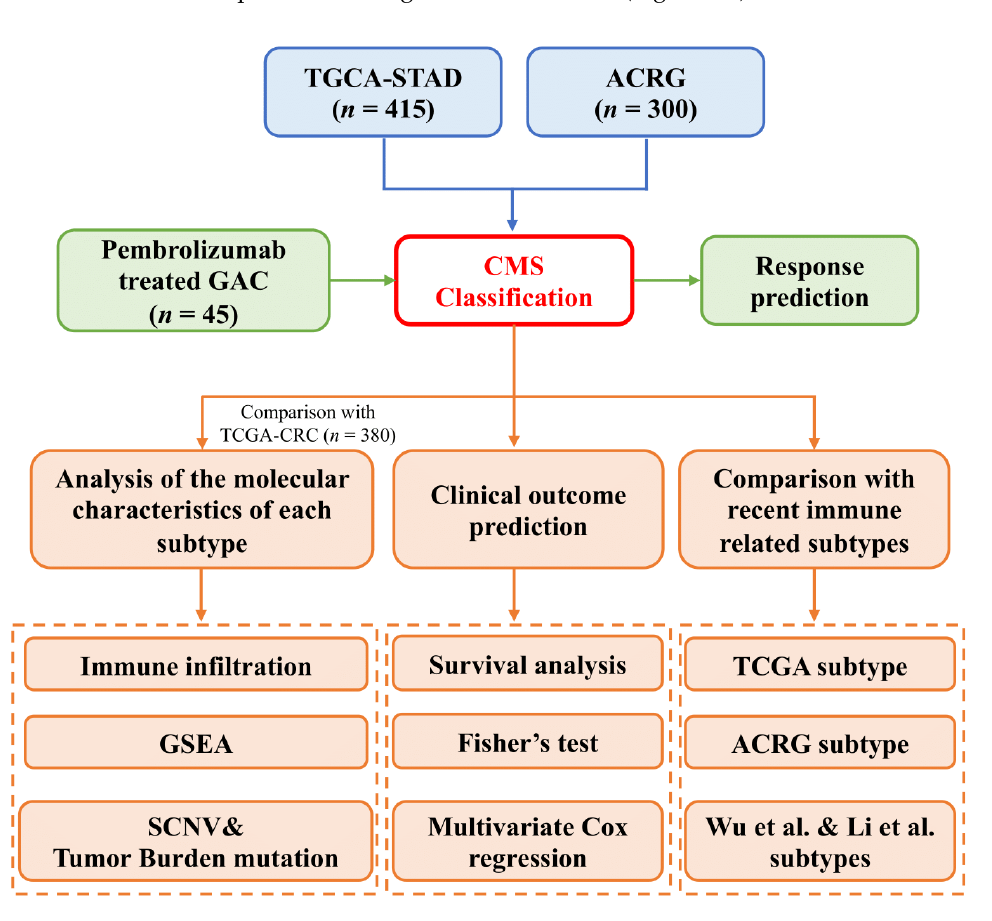
Figure 1. Analytical workflow showing the overall design of the study.